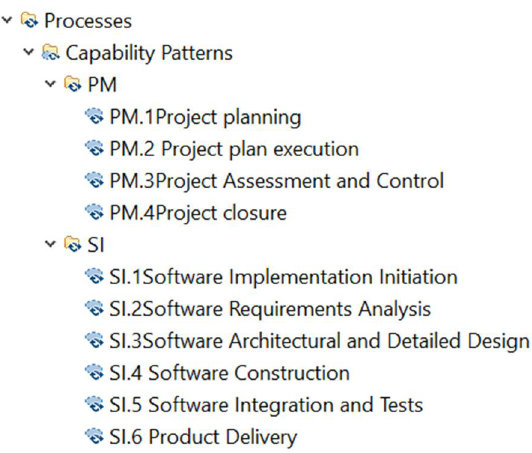
Figure 10. Structure of capability patterns in the EPF.